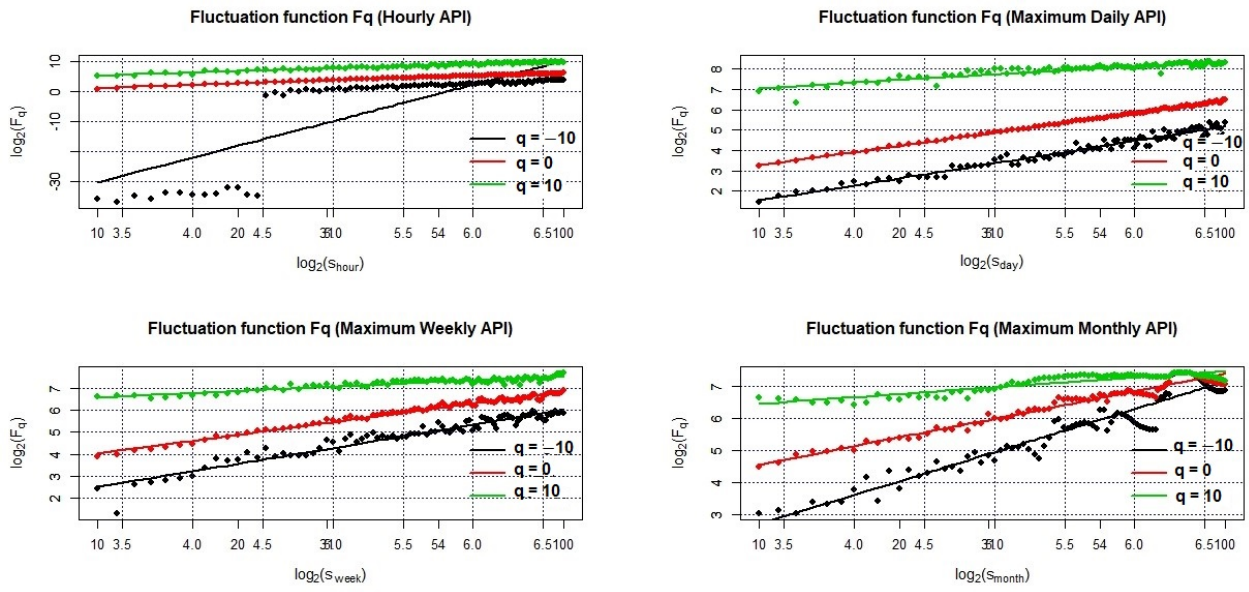
Figure 4. Plots of ln(s) versus ln(Fq(s)) on maximum air pollution indices series in Klang. Further investigation is carried out by analyzing the plots of Rényi/Mass exponents.